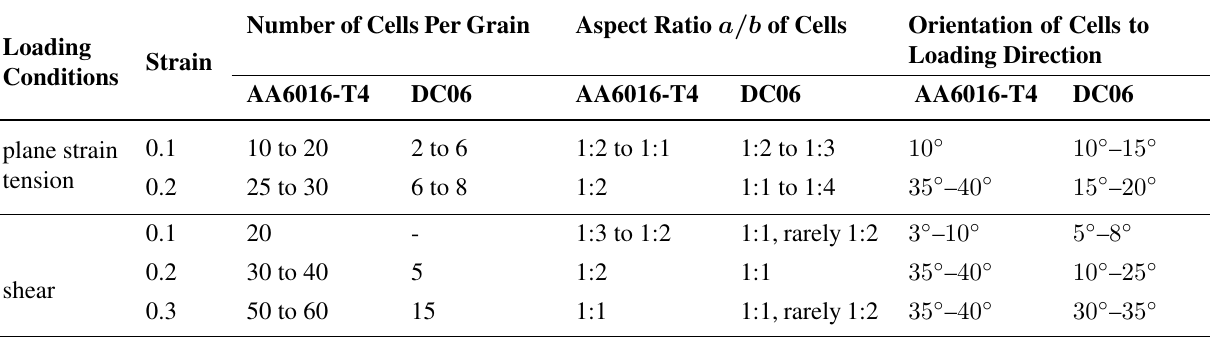
Table 5. Microstructural properties of the dislocation structures under plane strain tension, resp. shear loading, in aluminum AA6016-T4 and steel DC06 at various strain levels. Number of Cells Per Grain Aspect Ratio a/b of Cells Orientation of Cells to Loading Strain Conditions plane